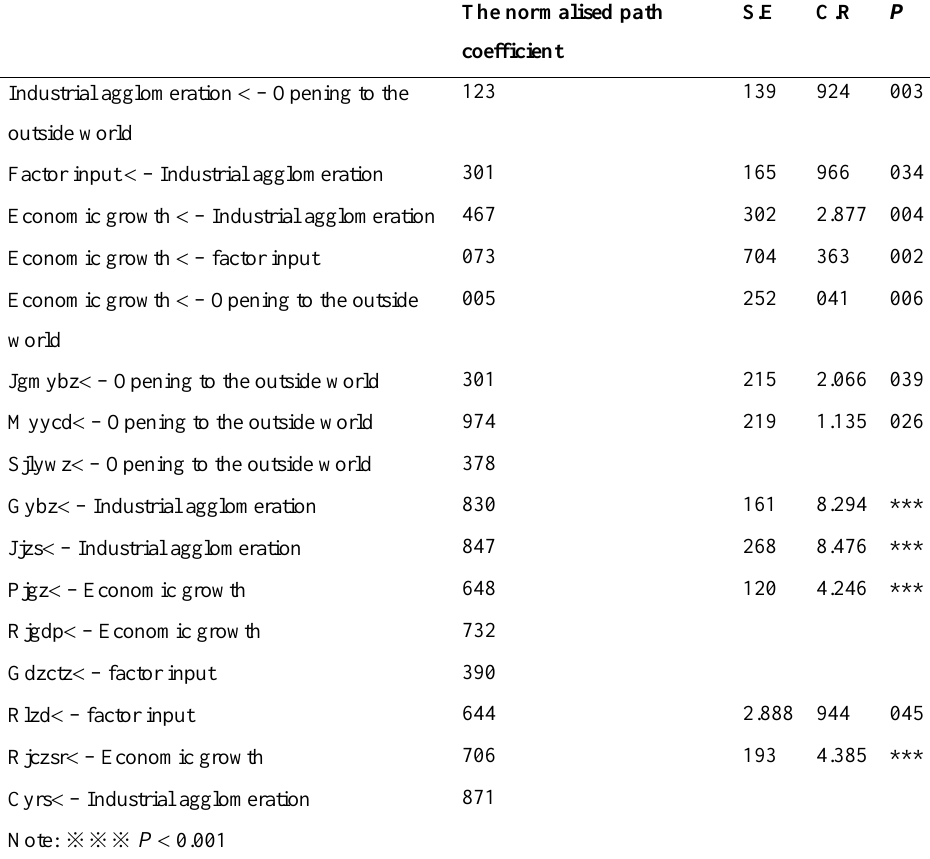
Table 4 Parameter estimation analysis